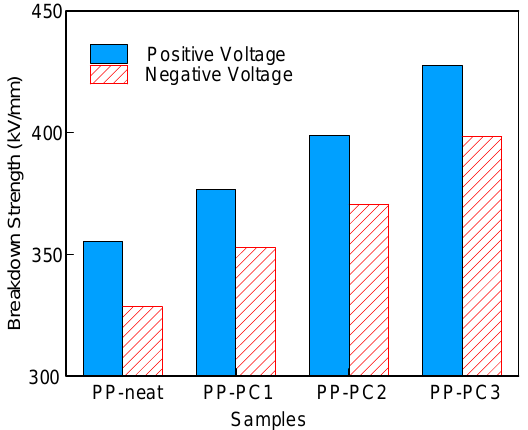
Figure 5. Characteristic breakdown strength of samples at 85 °C.